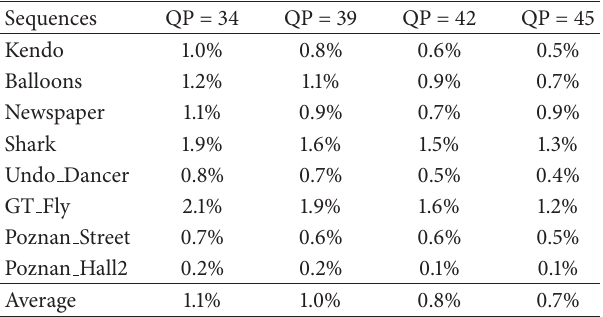
Table 1: Statistical analysis of intramode distributions in depth map